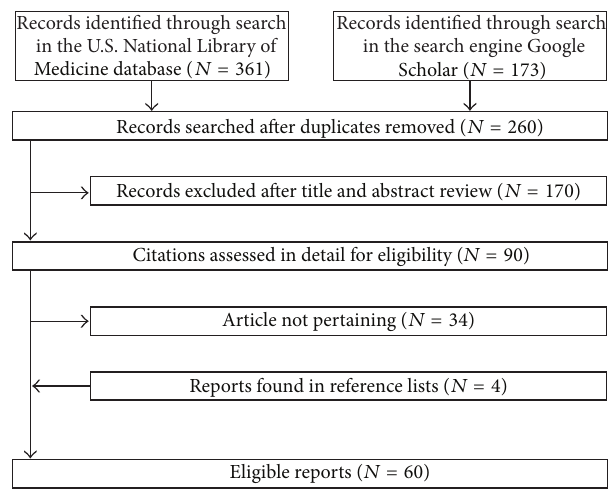
Figure 1: Flowchart of the literature search process. Five of the 60 eligible reports had been identified exclusively from the Web-based search engine Google Scholar.